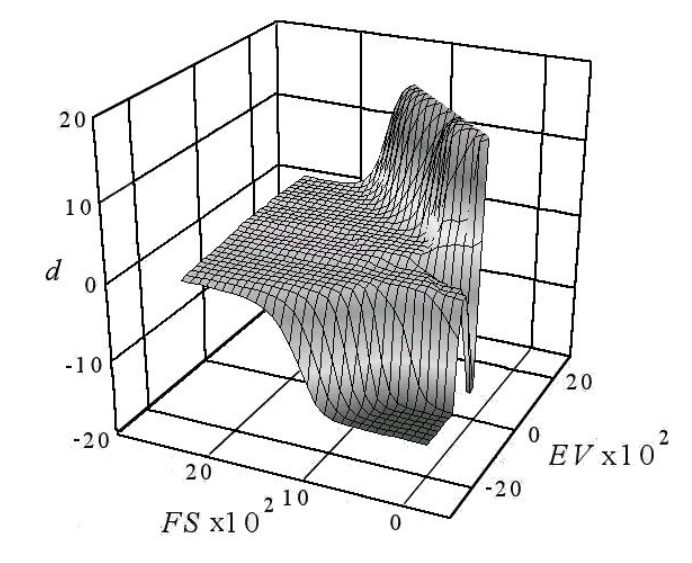
Figure 18. d divergence coefficient and chaos at peak